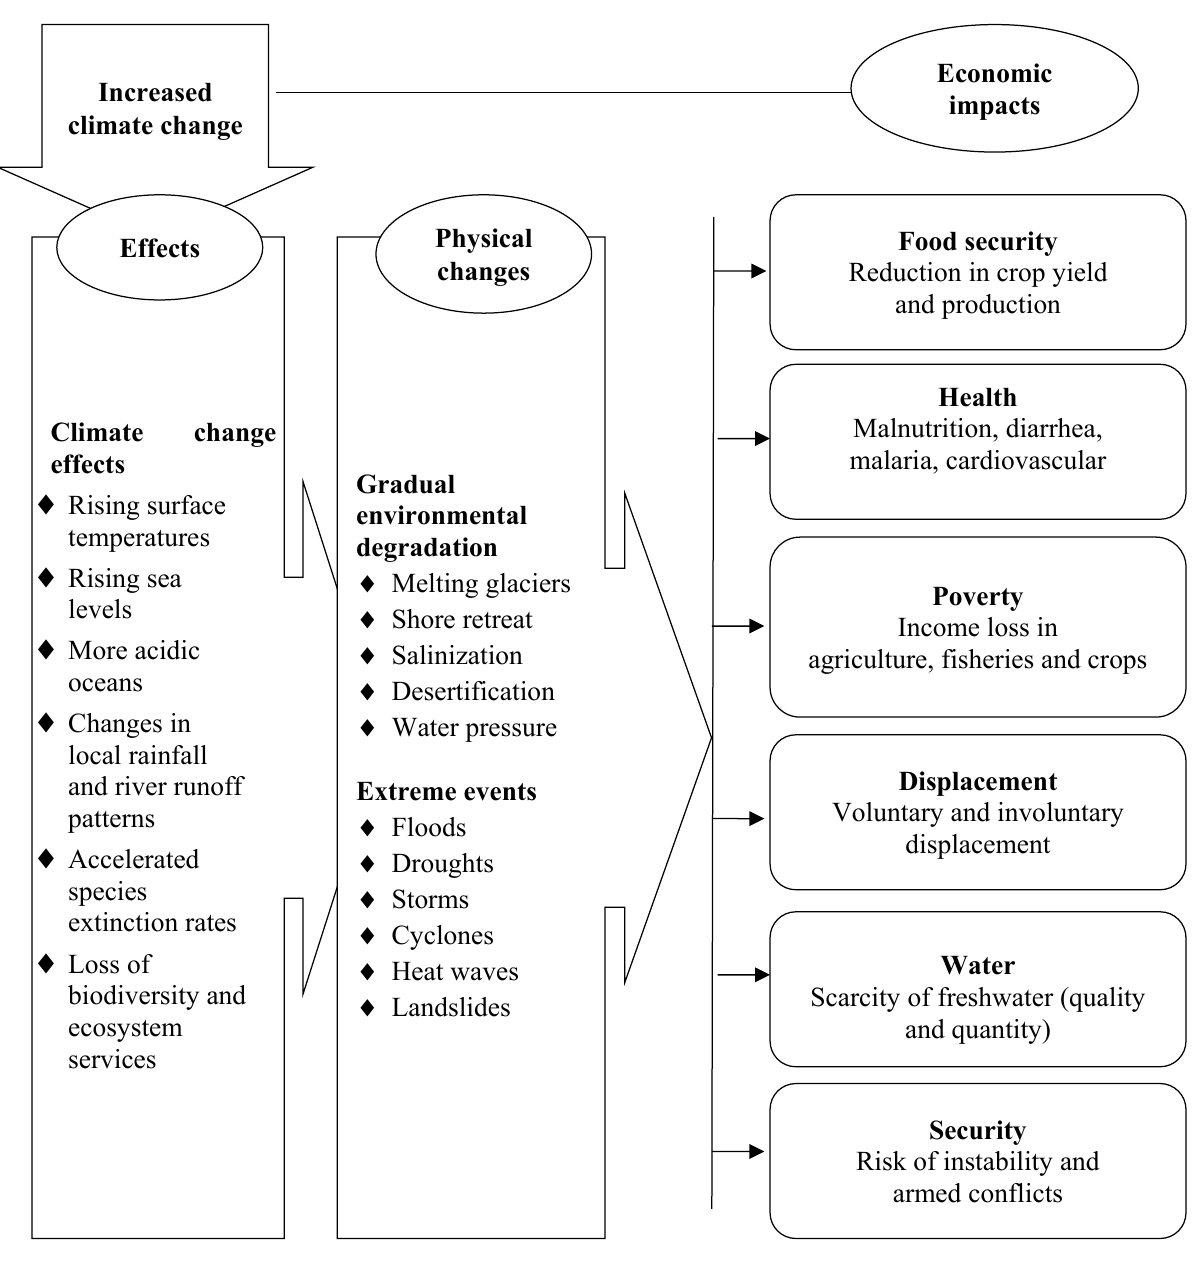
Fig. 1. Conceptual framework of the